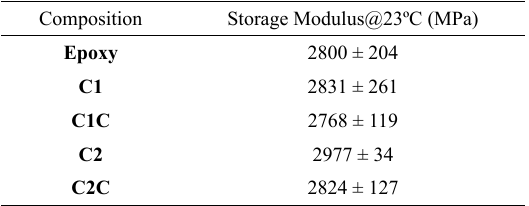
Figure 6. Storage modulus versus temperature for neat epoxy, epoxy/CNT nanocomposites with 0.05 and 0.1 wt % of CNT and epoxy/ CNT/calcium carbonate with 0.05 and 0.1 wt % of CNT. (a) Storage modulus versus temperature from 0 ºC to 150 ºC, (b) Storage modulus versus temperature from 0 ºC to 60 ºC. Table 2. Storage modulus determined via DMA for neat epoxy, epoxy/CNT nanocomposites with 0.05 and 0.1 wt % of CNT and